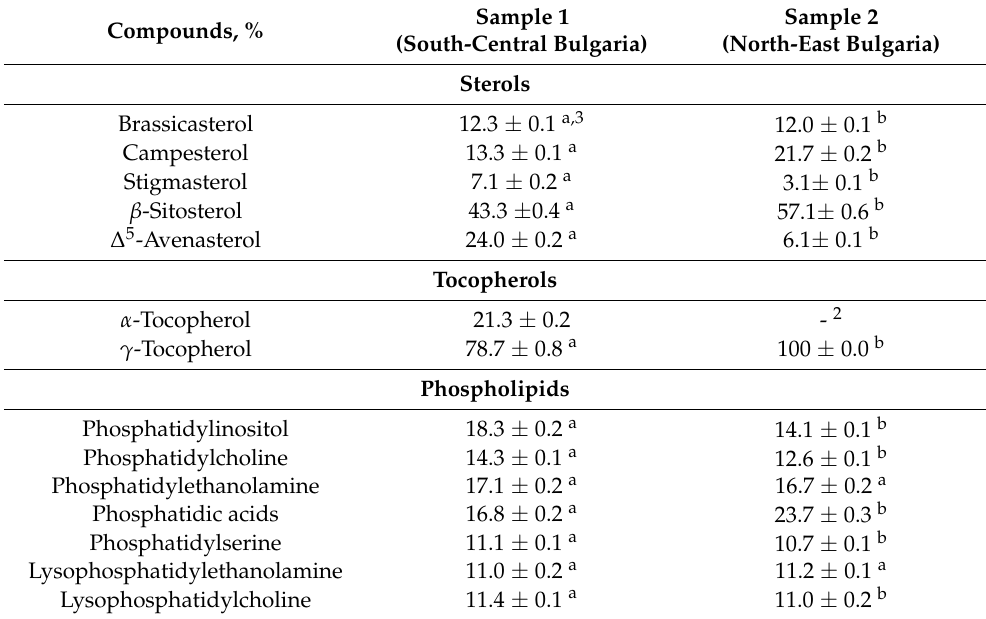
Table 6. Sterol, tocopherol and phospholipid composition of fruit vegetable oils 1 . Compounds,